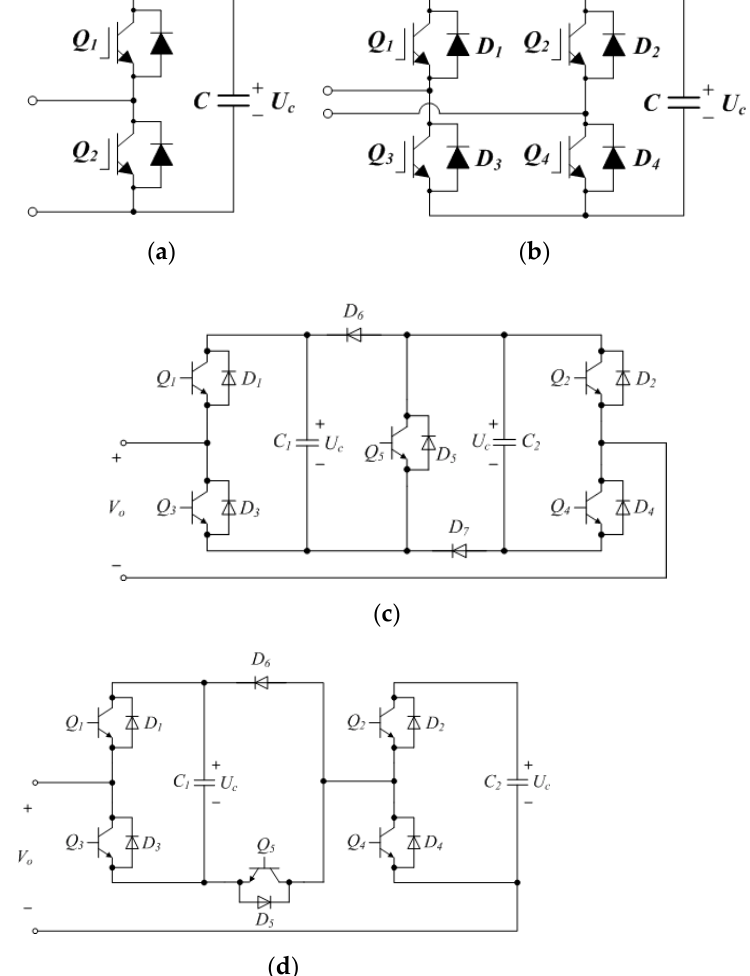
Figure 1. Circuit configuration of submodules: ( a ) HBSM, ( b ) FBSM, ( c ) CDSM, and ( d ) IHSM. The HVDC submodule provides or removes capacitor U C voltage to the converter.